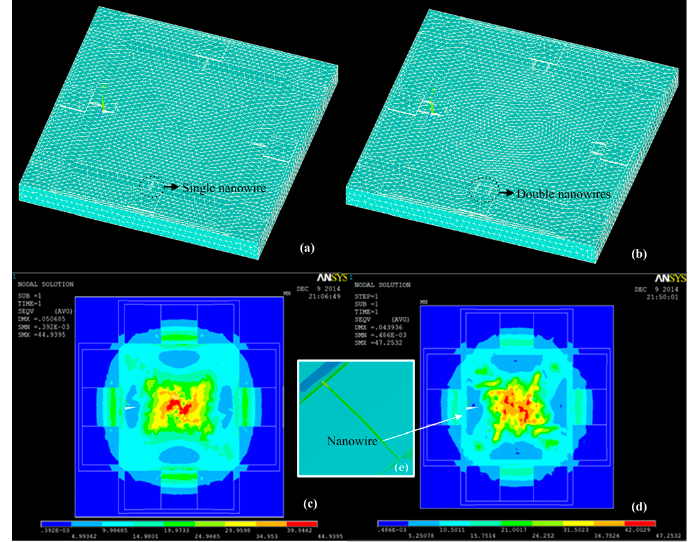
Figure 2. ( a ) Three-dimensional finite element mesh of single SiNW piezoresistive pressure sensor; ( b ) three-dimensional finite element mesh of double SiNW piezoresistive pressure sensor; ( c ) average stress distribution of single SiNW pressure sensor; ( d ) average stress distribution of double SiNW pressure sensor; and ( e ) average stress distribution of the SiNW.